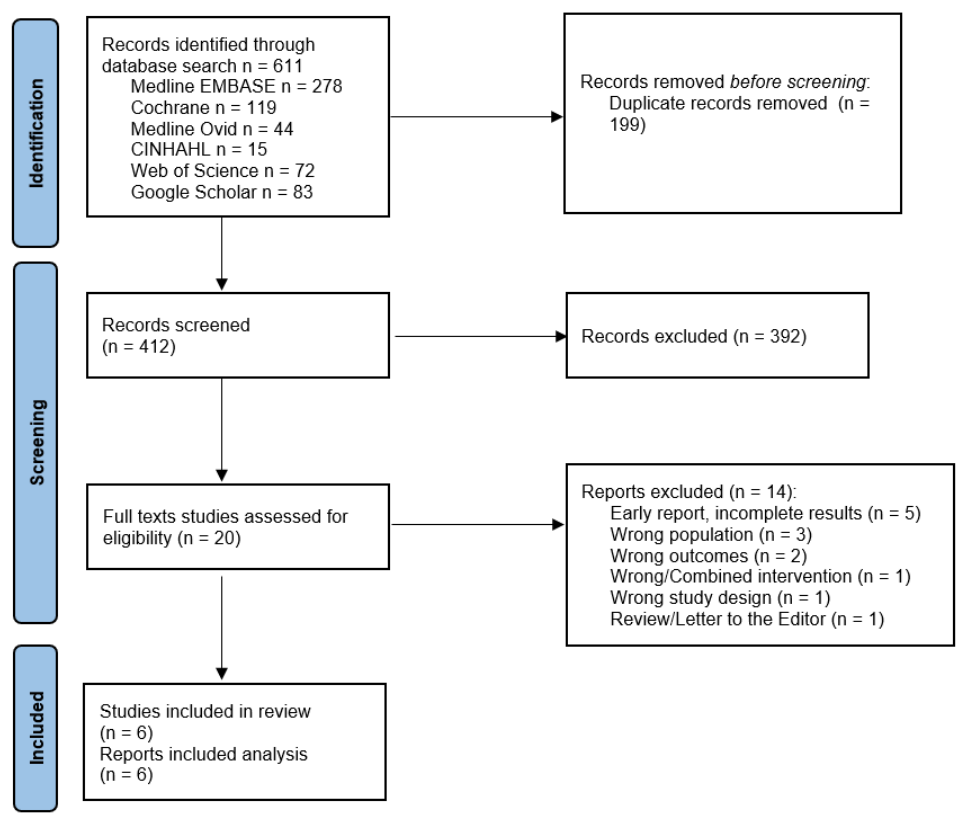
Figure 1. Prisma Diagram[15].